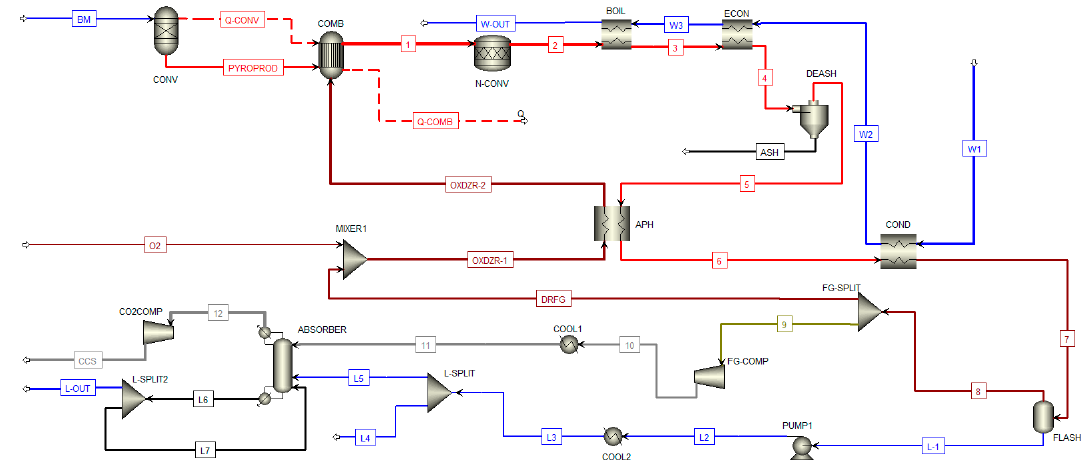
Figure 1. Oxy Biomass Combustion and CCS.